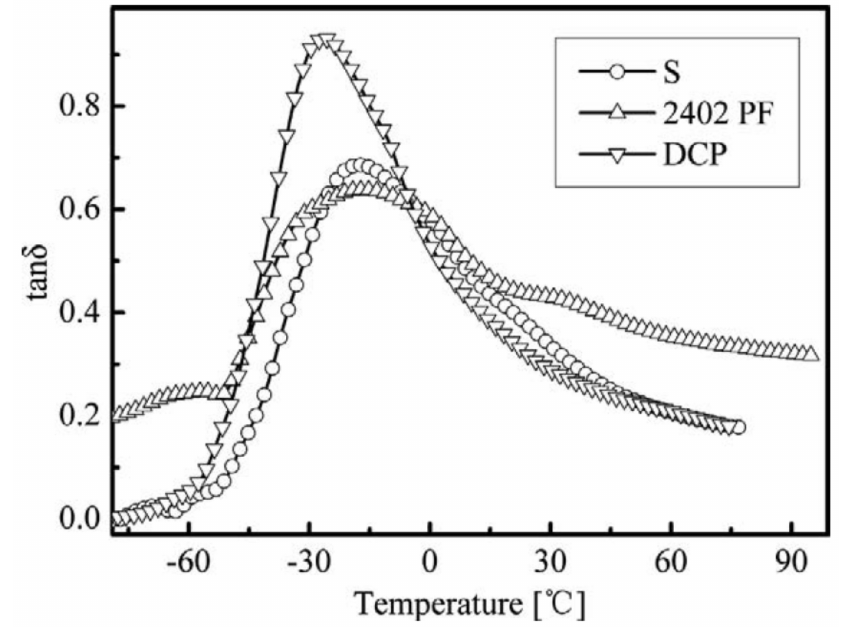
Figure 30. Evolution of the damping loss factor of ENR vulcanized by S, DCP and 2402 PF with respect to the temperature